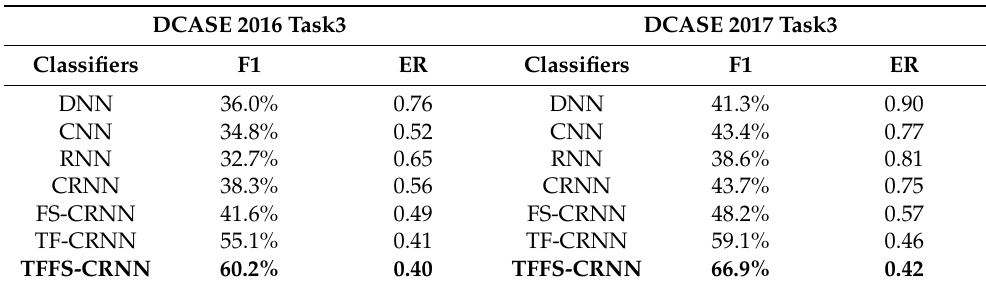
Table 5. The results of different